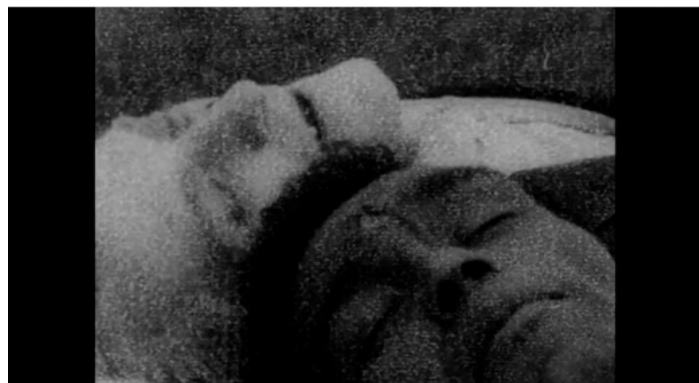
Figure 3. From the final sequence of Night of the Living Dead , the camera focuses on the faces of Ben and the film’s first zombie, emphasizing similitude.